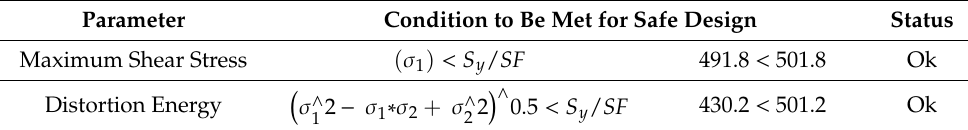
Table 3. Static Analysis Results using the theories of failure for ductile materials.